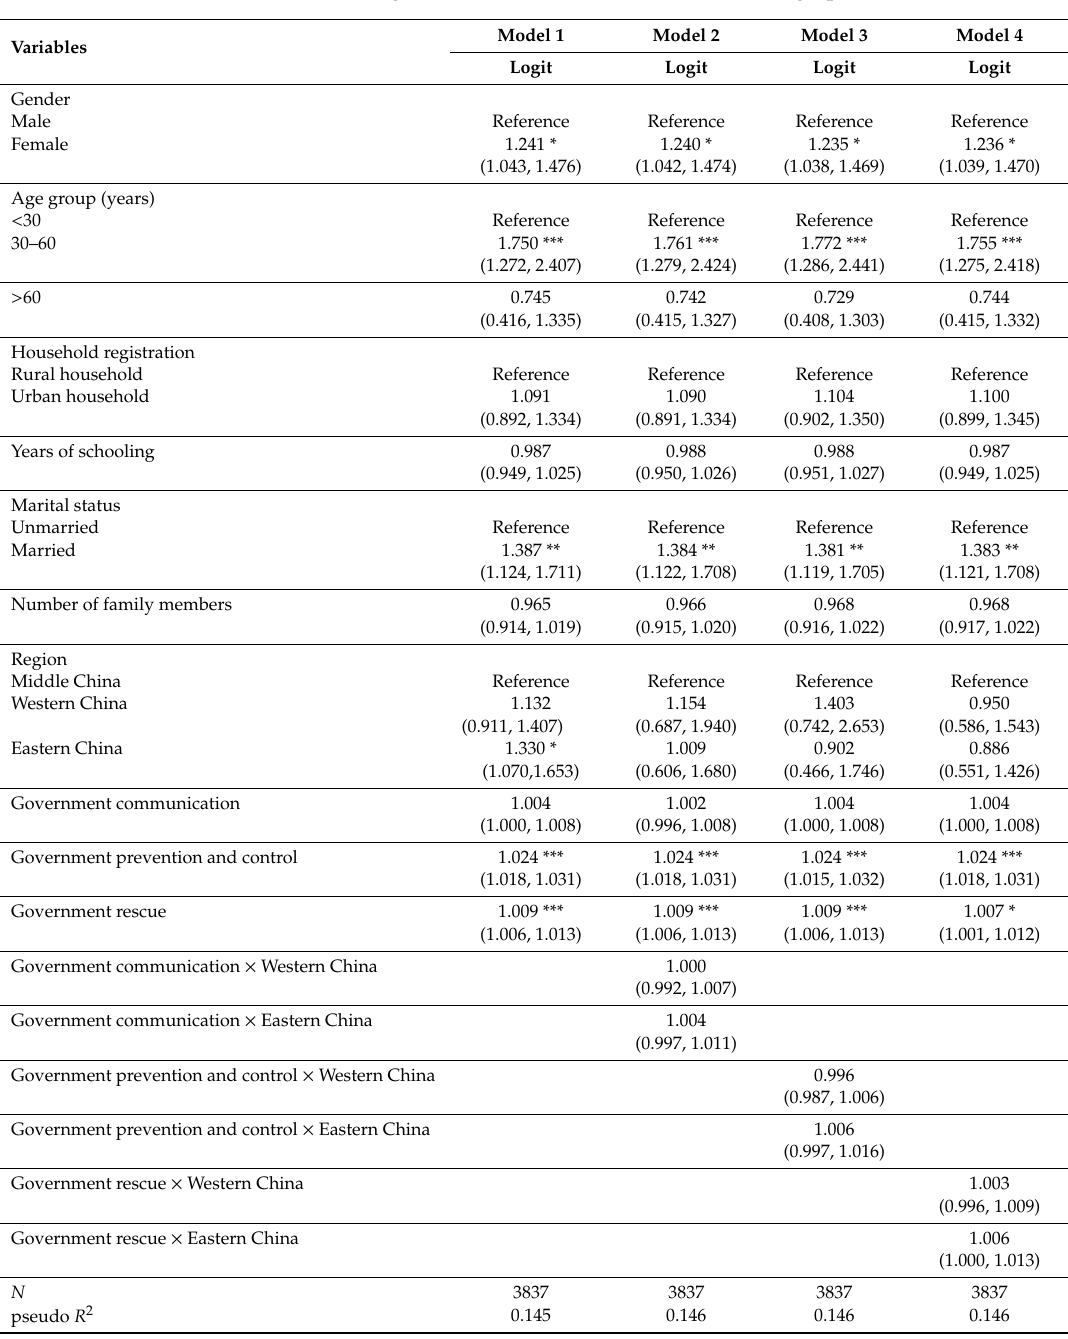
Table5. Oddsratiosand95%confidenceintervalsfromlogitmodelsofthepublic’sadoptionofprotective action recommendations (PARs) on government intervention and sociodemographic